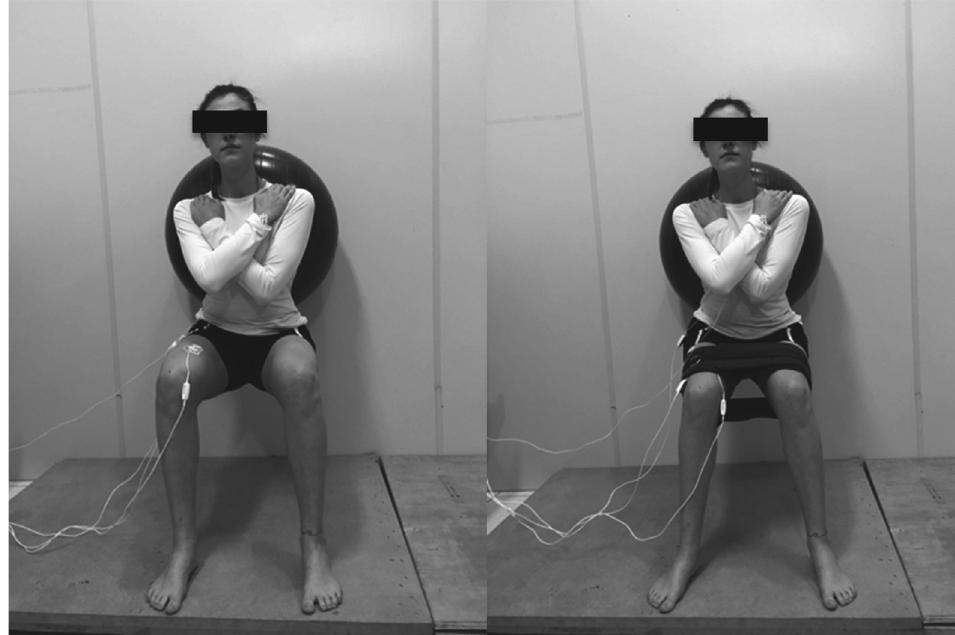
Figure 2 - Data collection of free squatting (left) and squatting with isometric hip abduction